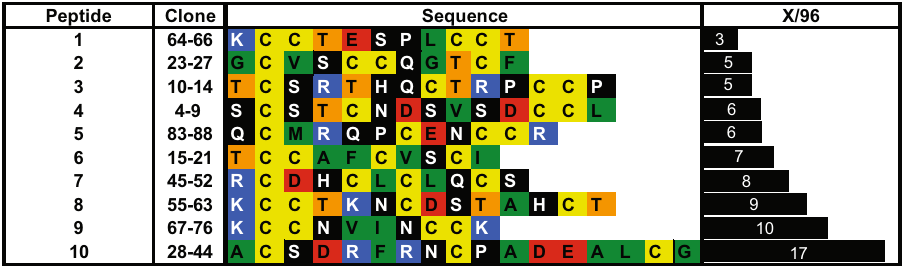
Fig. 2 Most abundant phage clones identi fi ed by phage display. Listed are the amino acid sequences and frequencies of occurrence of the ten most abundant phage clones. Clone numbers correspond to those presented in Supplementary Table 1.